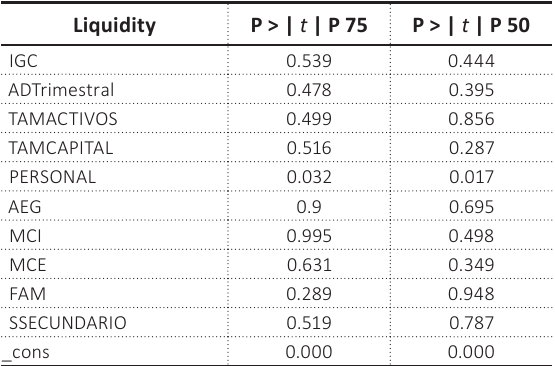
Table 6. Comparison of liquidity estimates